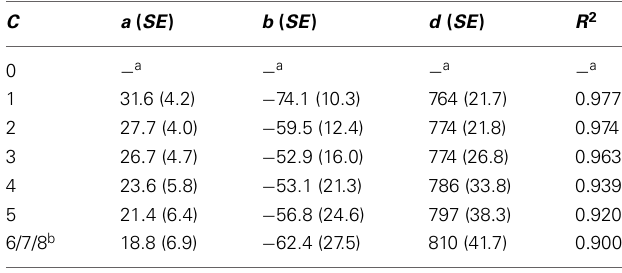
Table 2 | Summary of eight separate regression analyses predicting RT in Experiment 1 for the various priority tag